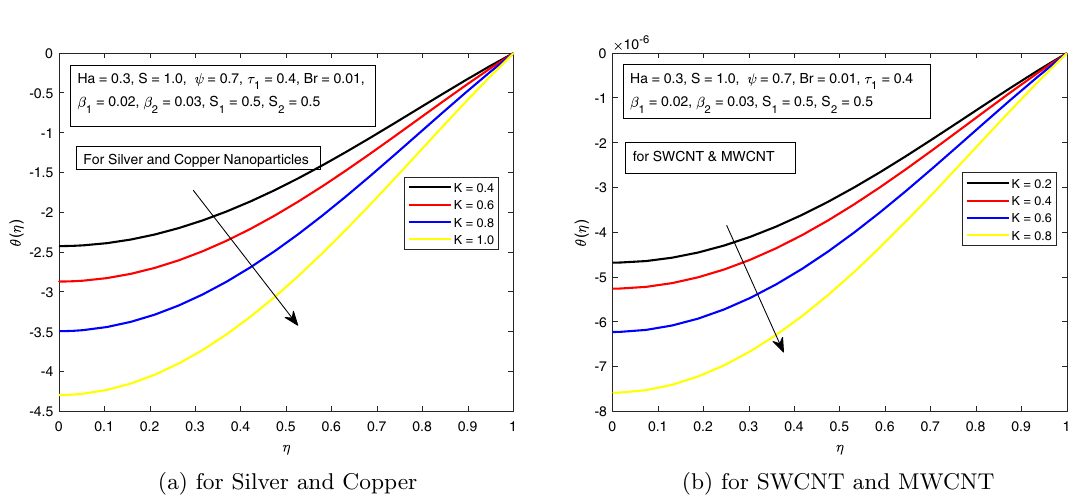
Figure 5. Influence of K on temperature distribution θ( r ) for the hybrid nanofluid combination of (a). Ag and Cu , (b) SWCNT and MWCNT